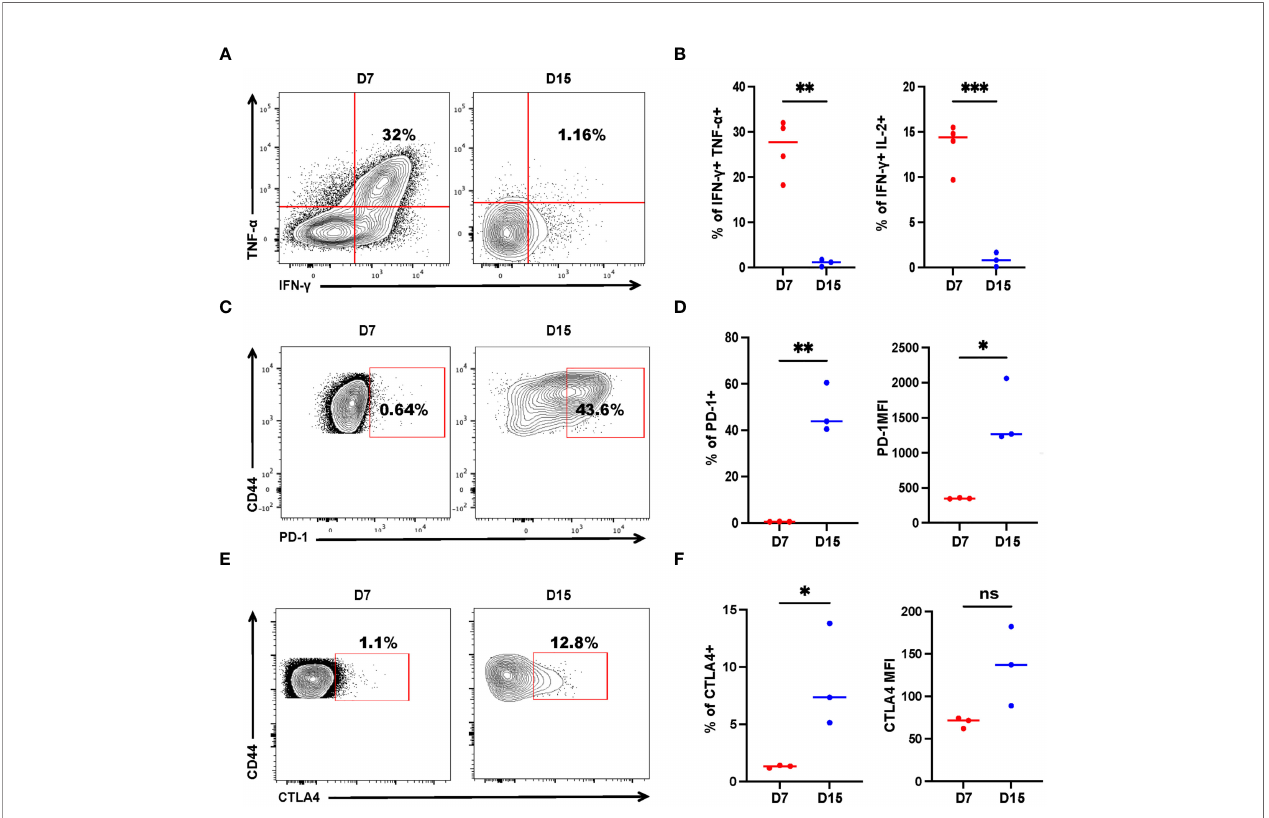
FIGURE 4 | Tumor-speci fi c CD4 + T cells get exhausted during tumor progression. Tumor-bearing mice were treated with 2 × 10 6 activated SMARTA cells eight days after tumor inoculation and sacri fi ced on Day 7 or Day 15 post-transfer. Cells are gated on live CD4 + CD44 + CD45.1 + cells. (A, B) Representative fl ow cytometry plots of intracellular cytokine staining of CD4 + SMARTA cells on Day 7 (n=4) and Day 15 (n=3) post-SMARTA transfer (A) . The frequencies of IFN- g + TNF- a + and IFN- g + IL-2 + cells of CD4 + SMARTA cells (B) . (C, D) In a separate experiment, representative fl ow cytometry plots of PD-1 expression in CD4 + SMARTA cells on Day 7 and Day 15 (n=3/group) post-transfer (C) . The frequency of PD-1 + SMARTA cells and MFI of PD-1 (D) . (E, F) Representative fl ow cytometry plots of CTLA4 expression in CD4 + SMARTA cells on Day 7 and Day 15 (n=3/group) post SMARTA transfer (E) . The frequency of CTLA4 + SMARTA cells and MFI of CTLA4 (F) . Statistical differences are calculated by unpaired t -test. ns, not signi fi cant, * p < 0.05, ** p < 0.01, *** p <